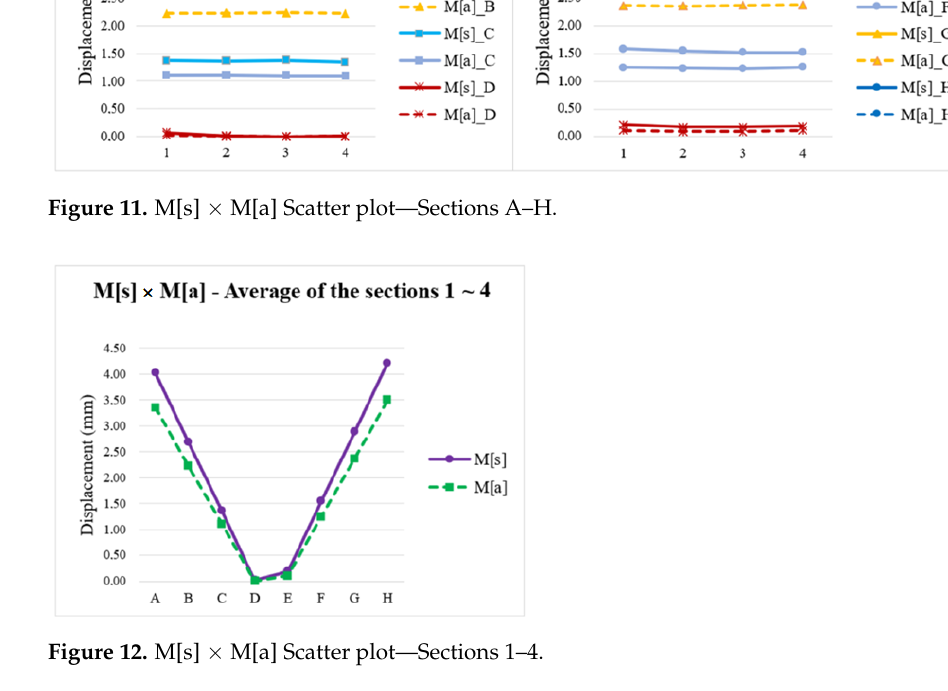
Table 3. Summation of the sample distortions in multipass welding.